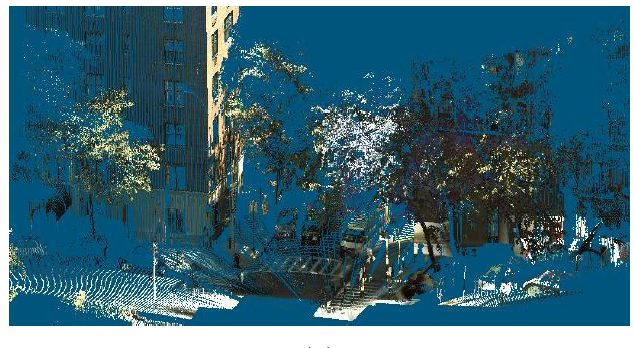
Figure 10. Segmentation and classification results for a particular scene-B of scenes from 3D Urban Data Challenge 2011, image # ParkAvenue SW12 piece00 [36]. (a) 3D data points—shows 3D data points of data set 1. (b) Voxelisation and segmentation into objects—shows s -voxel segmentation of 3D points (along with orientation of normals). (c) Labeled points—shows classification results (labeled 3D